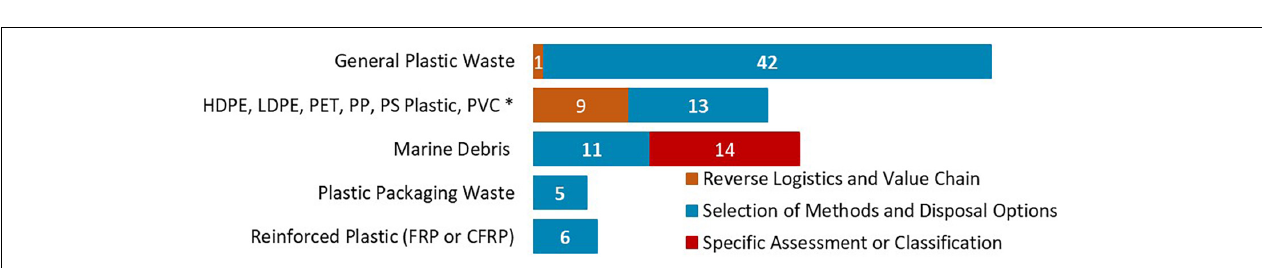
FIGURE 2 | Number of papers per setting (marine or terrestrial), geography, and year.